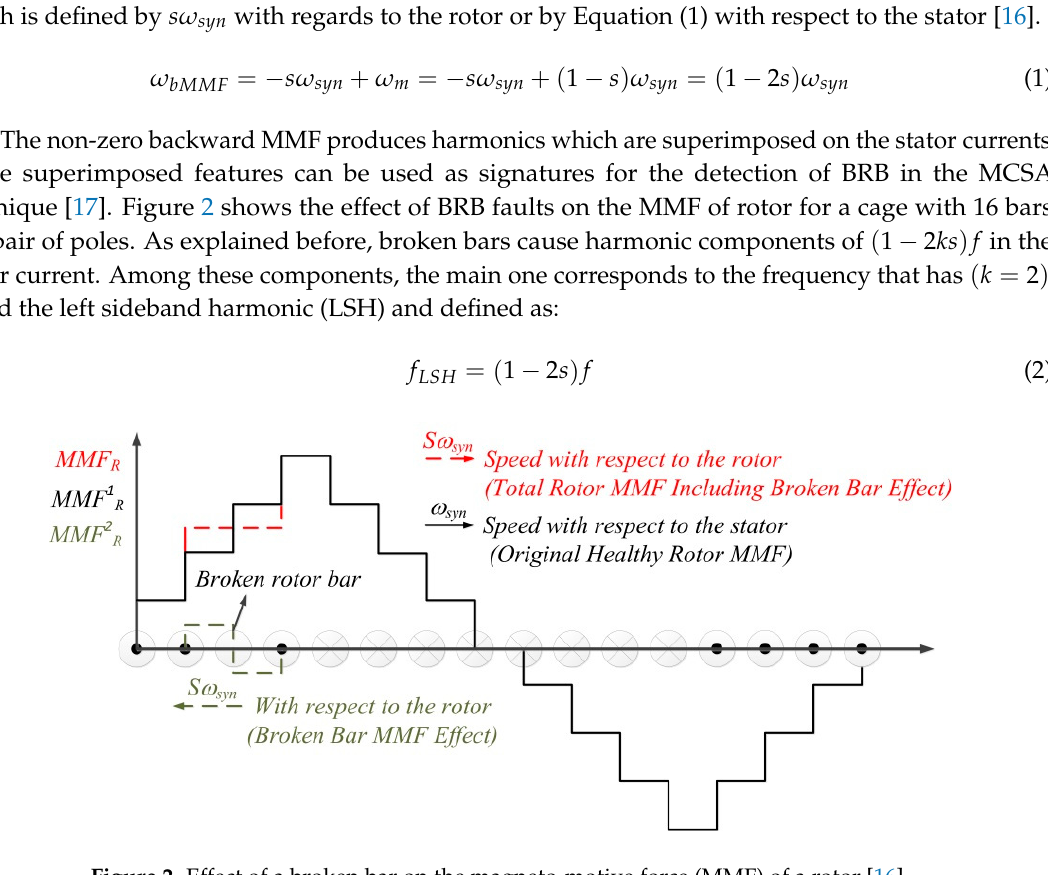
Figure 2. Effect of a broken bar on the magneto-motive force (MMF) of a rotor [16].